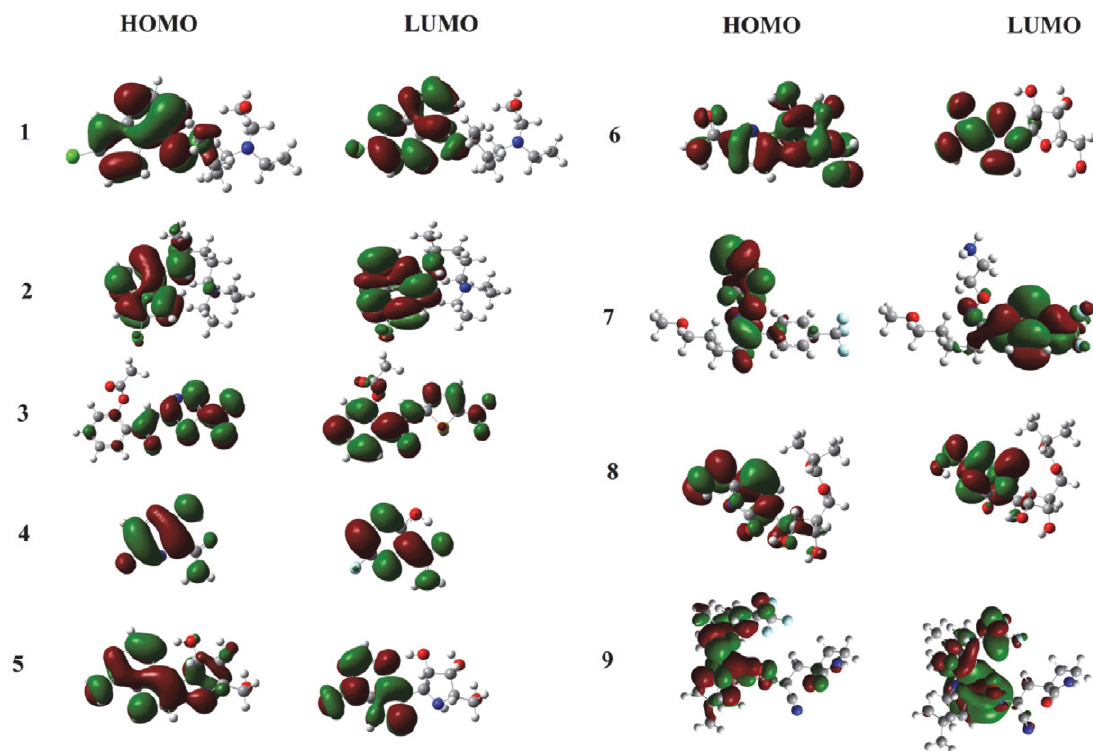
Figure 4 Frontier molecular orbitals of drug